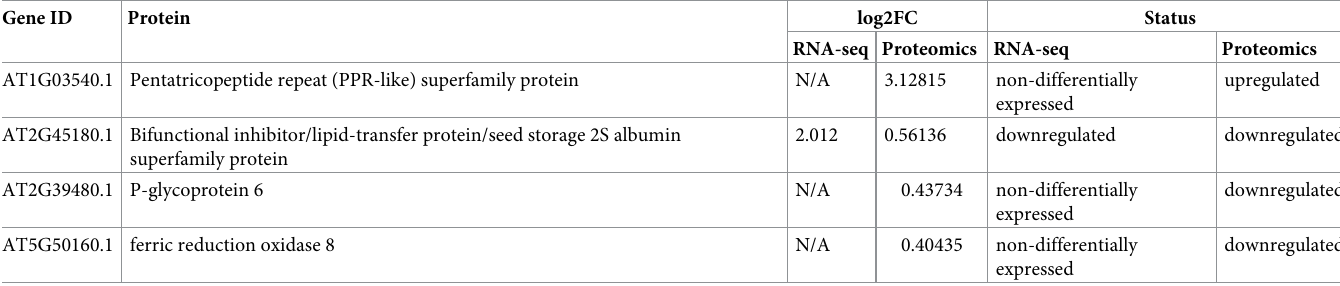
Table 1. Comparison between RNA-seq data and proteomics data of selected protein